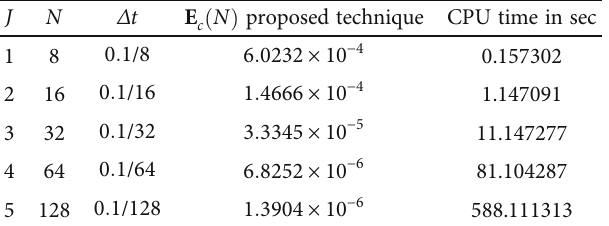
Table 6: Analysis of errors Example